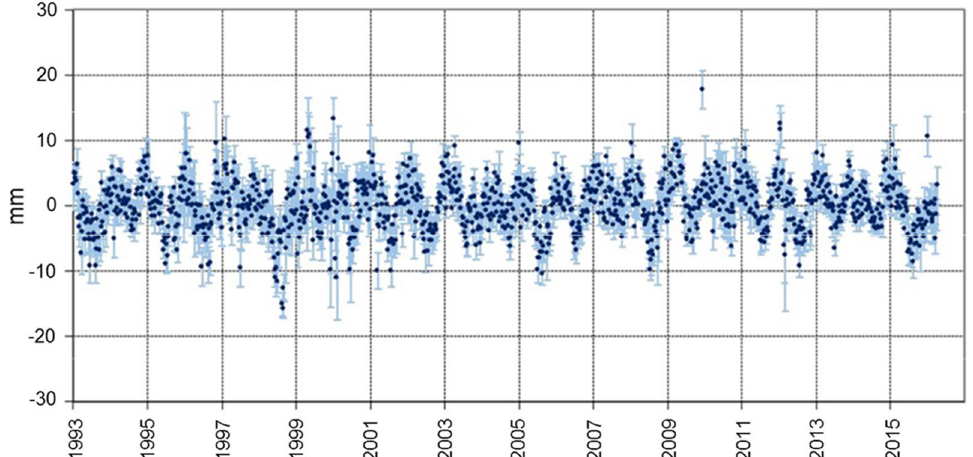
Fig. 3 SLR‑derived geocenter motion, X component (ILRSA combined solution,